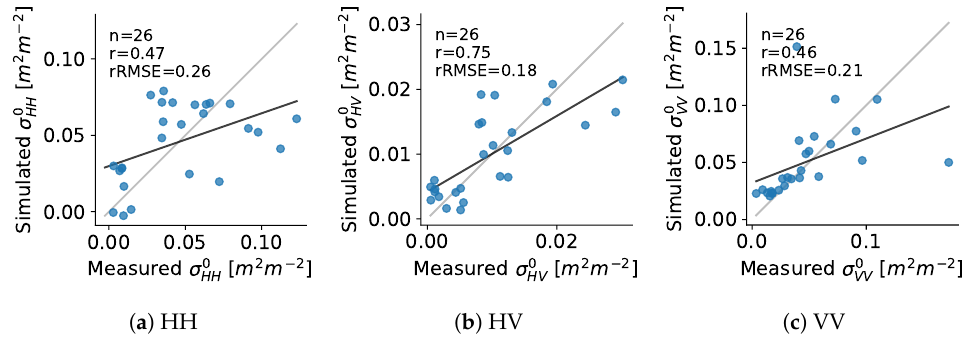
Figure 9. Results from the leave-one-out cross-validation (LOOCV) for the calibration of the water cloud model (WCM) with L-band data in ( a ) horizontal co-polarization, HH; ( b ) cross-polarization, HV; ( c ) vertical co-polarization,